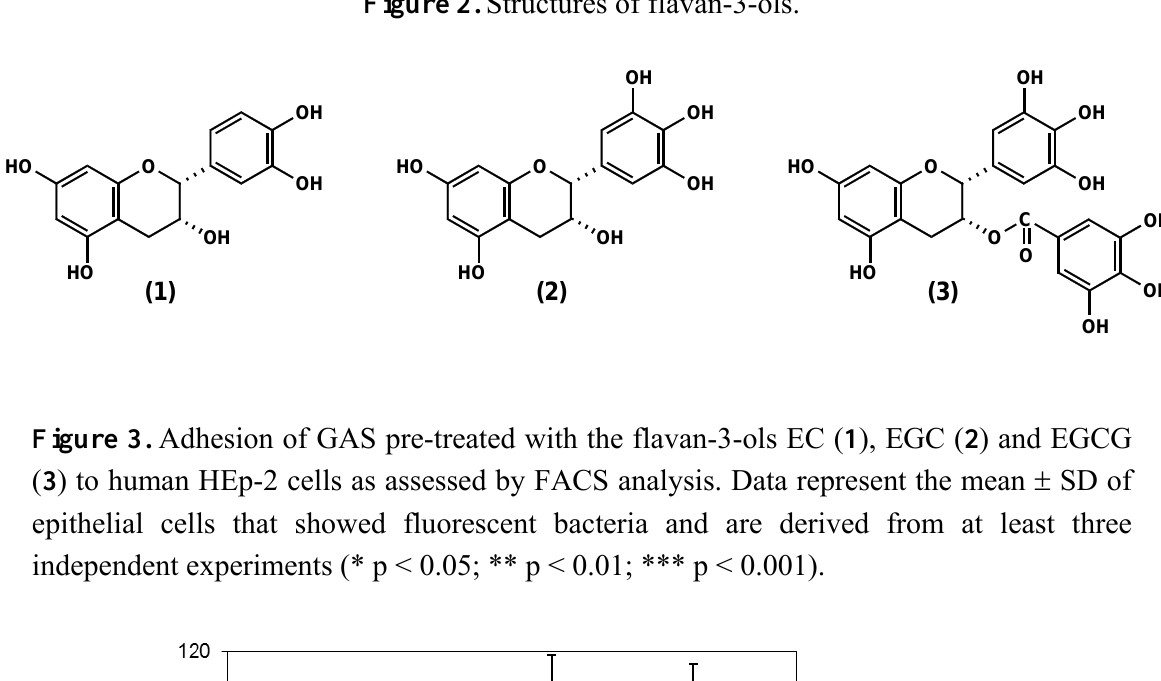
Figure 2. Structures of flavan-3-ols.